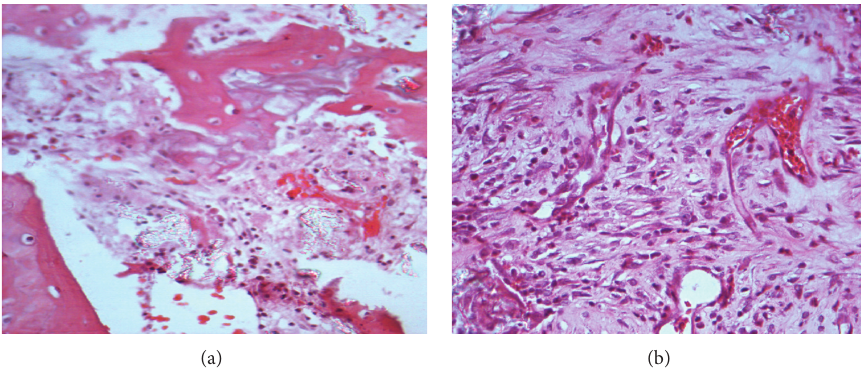
Figure 5: In the first four weeks after the end of the extension: (a) the histologically morphological observations of the extension area of group A and (b) the histologically morphological observations of the extension area of group B.